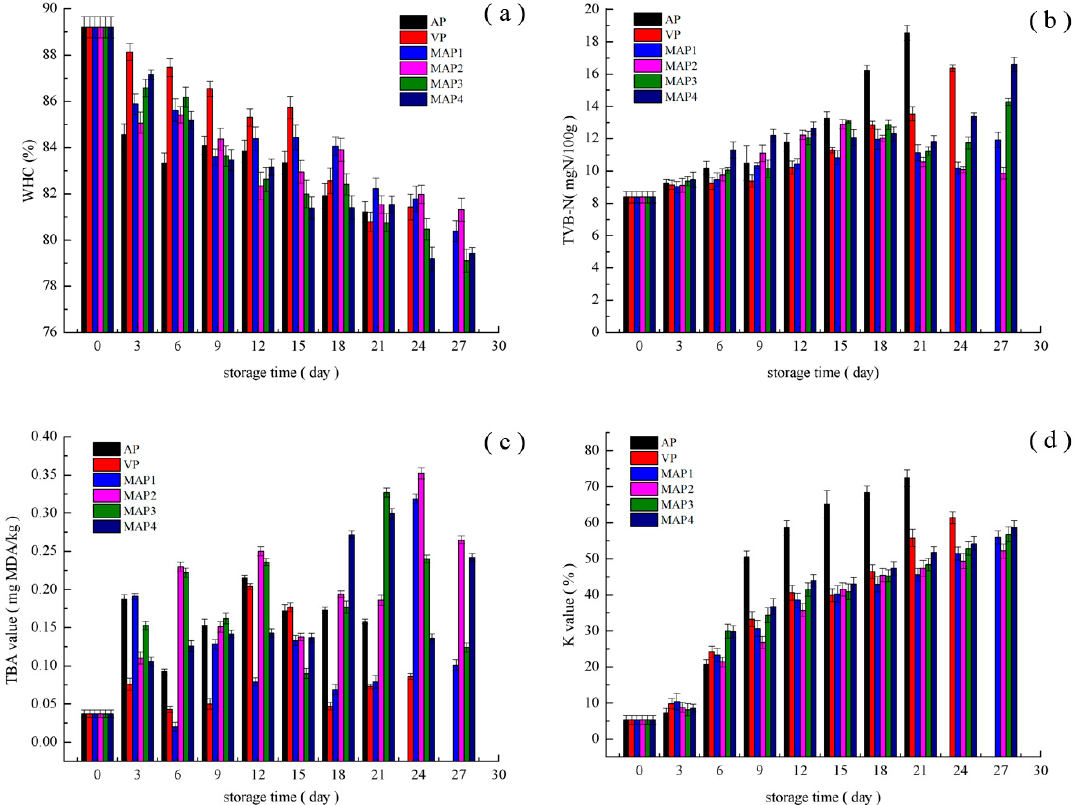
Figure 1. Changes in water holding capacity (WHC) ( a ), TVB-N value ( b ), TBA value ( c ) and K